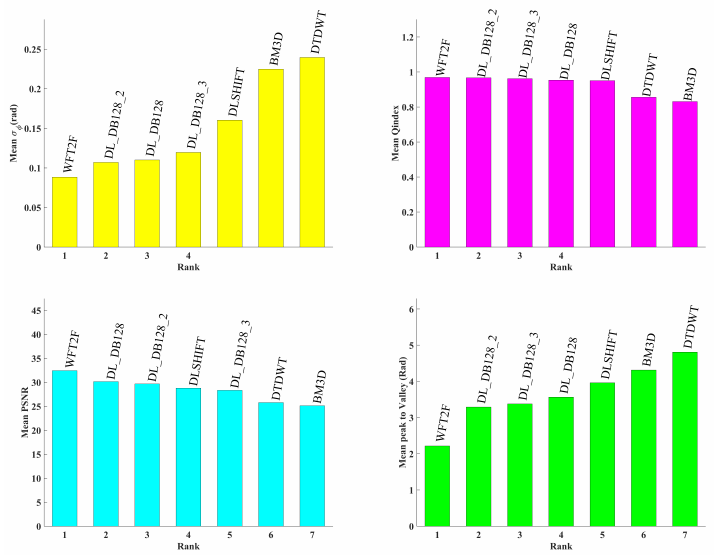
Figure 3. Rankings of metrics on DB128-test. From left to right and top to bottom : phase error, Qindex, PSNR and